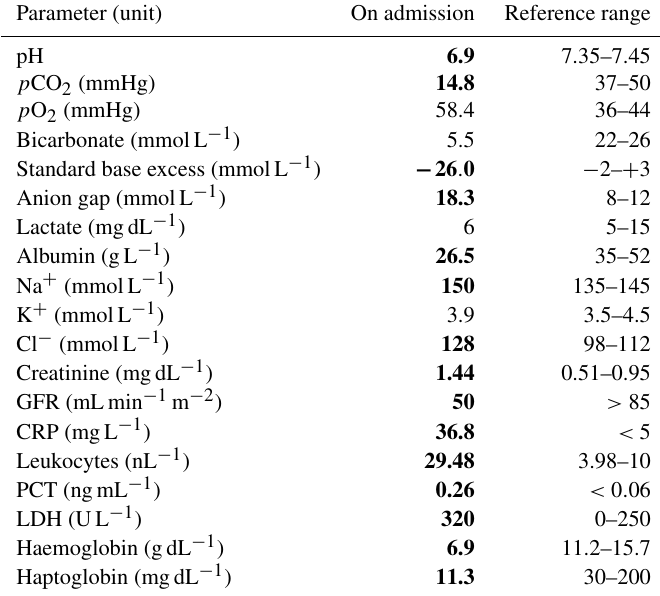
Table 1. Venous blood gas analysis and laboratory values on admission of the patient to the intensive care unit. Bold font: laboratory values outside the reference range. GFR represents glomerular filtration rate, CRP represents C-reactive protein, PCT represents procalcitonin, and LDH represents lactate